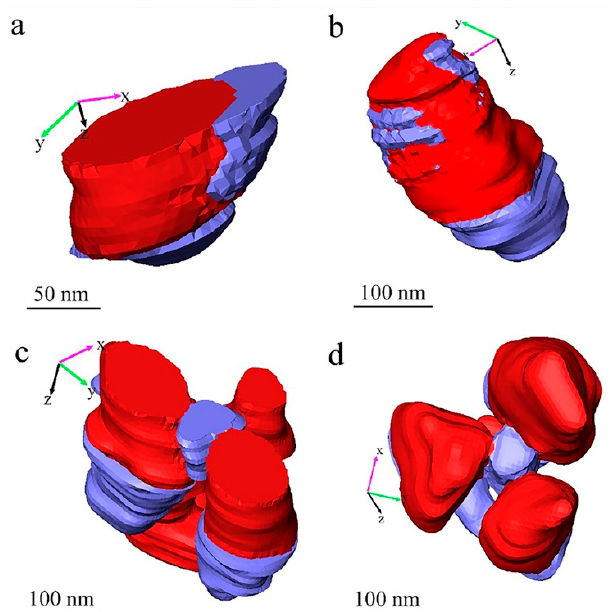
Figure 6. 3D rendering of different voids in the TiO 2 pigmented waterborne paint: ( a ) Voids around a TiO 2 particle near the surface of the waterborne paint film; ( b ) Voids around a TiO 2 particle in the waterborne paint film; ( c ) Voids around a tiny cluster of TiO 2 particles near the surface of the waterborne paint film; ( d ) Voids around a tiny cluster of TiO 2 particles in the waterborne paint film. The red parts are TiO 2 particles and the blue parts are voids.